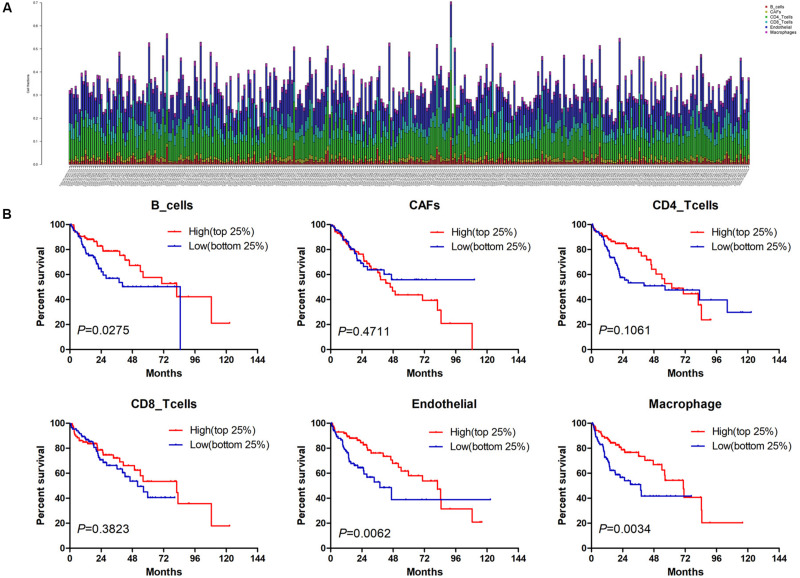
The prognostic value of six cell fractions in HCC patients from TCGA. (A) The composition of six cell fractions in HCC patients (n = 343). (B) The OS analysis of HCC patients with top (n = 86) and bottom 25% (n = 85) infiltration level of six cell fractions.